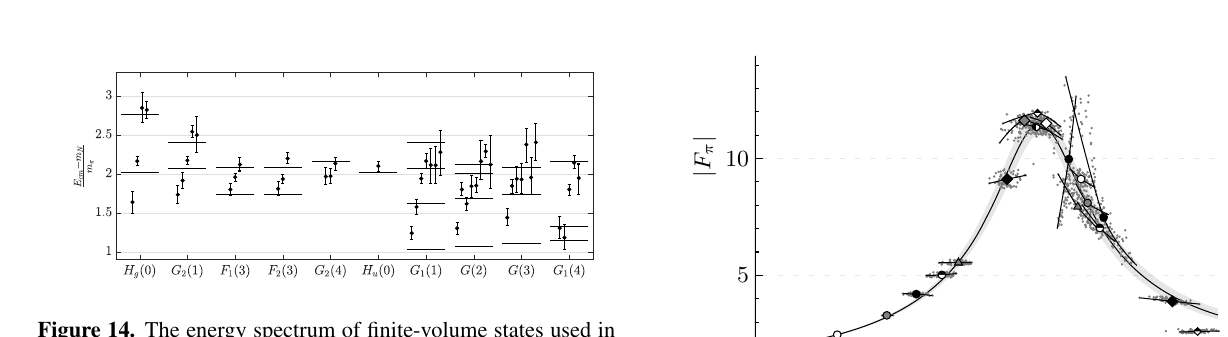
Figure 14. The energy spectrum of finite-volume states used in our most recent study in Ref. [17] of the Δ resonance. Di ff er- ences of the center-of-mass energies from the nucleon mass as a ratio over the pion mass are shown for the di ff erent irreps and total momenta used. Horizontal lines show the non-interacting energies.